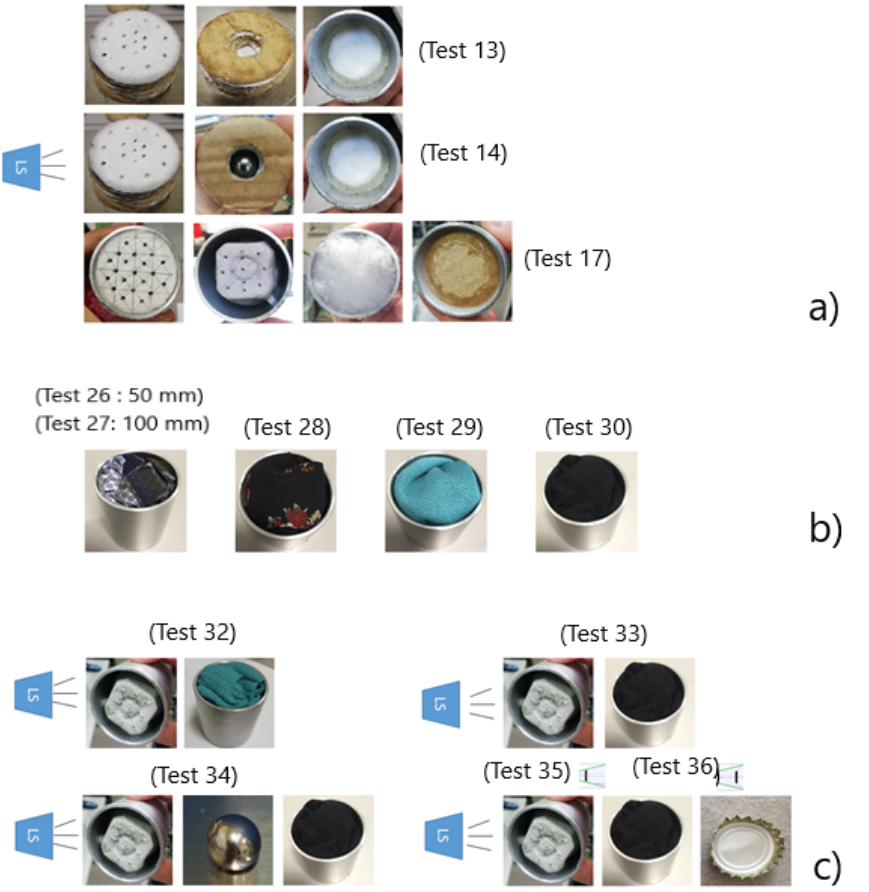
Figure 8. Configurations analyzed with the impedance tube: ( a ) samples made of several layers of cardboard, ( b ) samples made of clothes (one fabric at a time), ( c ) samples made of egg-boxes and